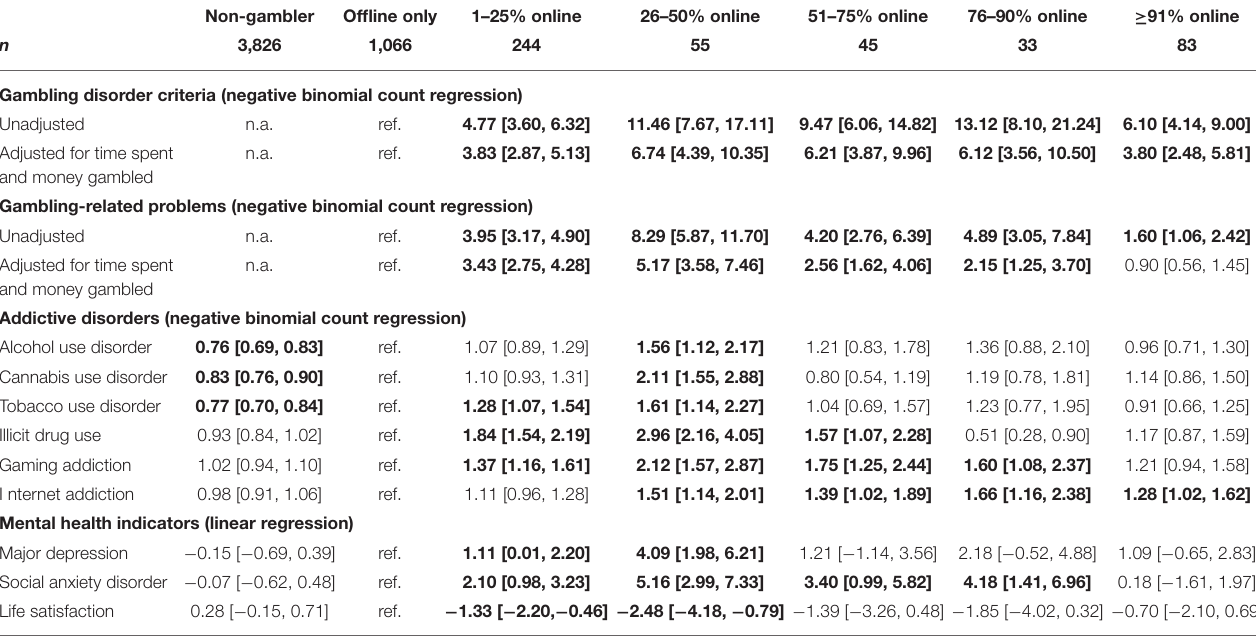
TABLE 4 | Negative binomial regression (IRR [95% CI]) on gambling disorder criteria, gambling problems, other addictive disorders and mental health variables by proportion of money gambled online.